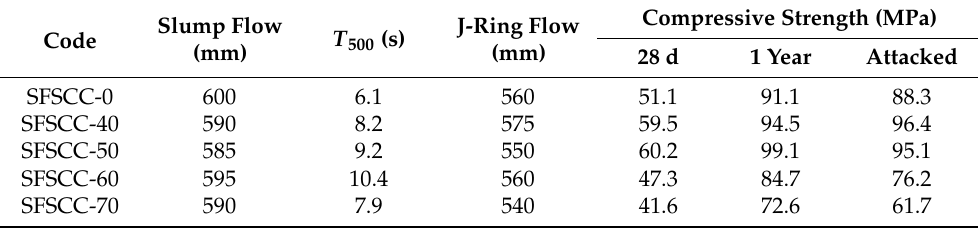
Table 4. The physical mechanical properties of SFSCC.